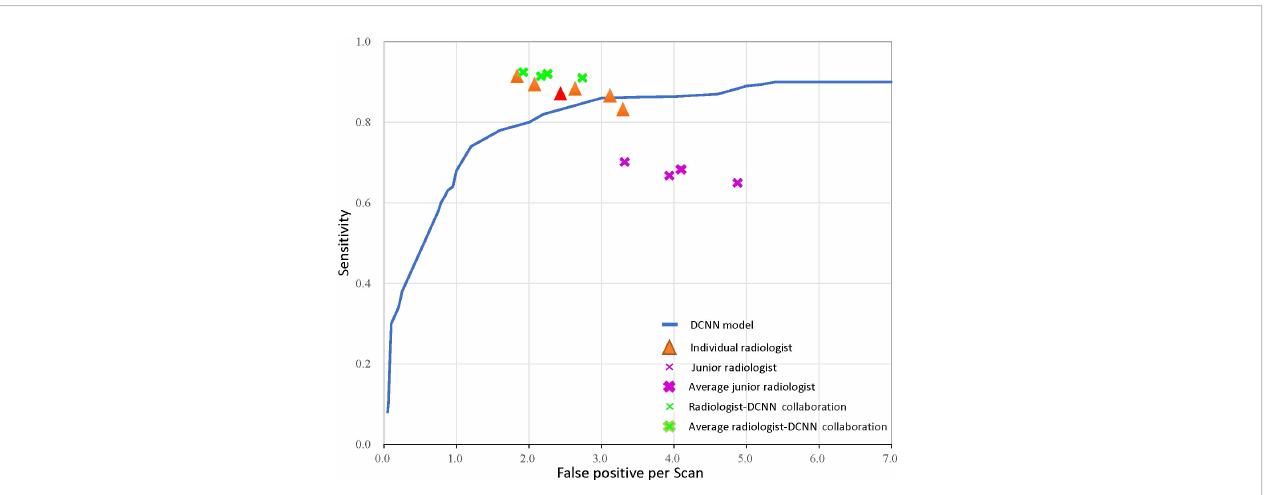
FIGURE 4 The receiver operator characteristic curve for the performance of the deep convolutional neural network (DCNN) model-only, radiologist-only, junior radiologist-only, and junior radiologists-DCNN model collaboration detection performance. Each orange triangle represents the performance of an individual radiologist; each pink fork represents the performance of a junior radiologist without the aid of DCNN; and each green fork represents the performance of a junior radiologist with the aid of DCNN. The red triangle indicates the average value of fi ve radiologists, and the bolded forks indicate the average value of junior radiologists.